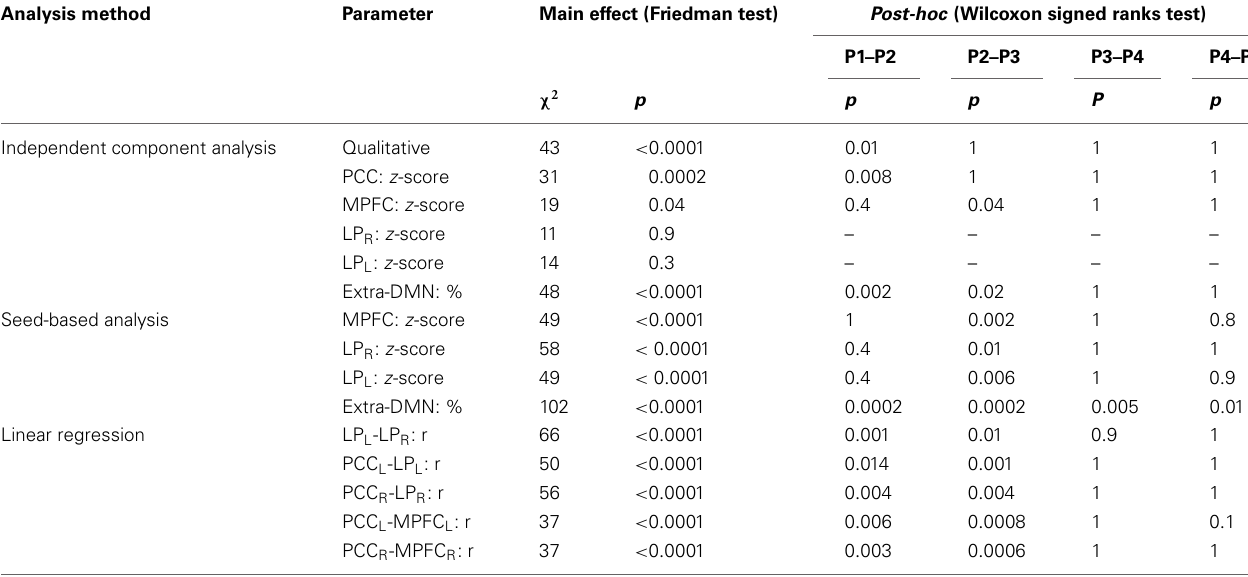
Table 3 | Statistical evaluation of the effect of the preprocessing procedures for patients.